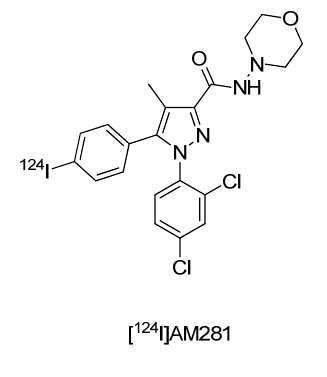
Figure 1. Central cannabinoid CB